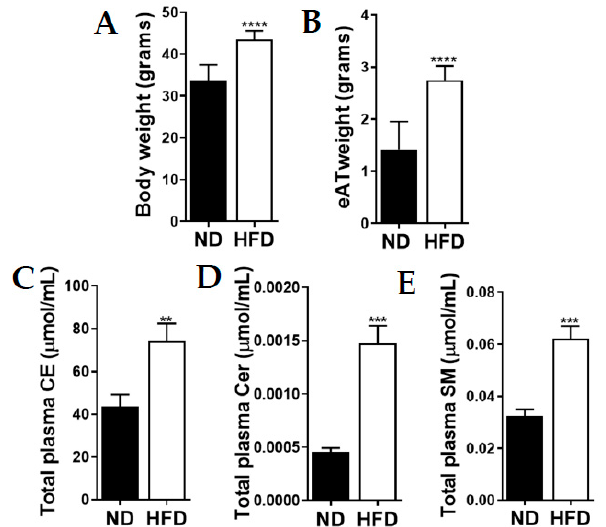
Figure 1. High-fat diet (HFD)-fed mice ( A ) weighed significantly more and showed ( B ) heavier epididymal adipose tissue (eAT) than normal diet (ND)-fed mice. HFD mice also showed elevated total fasting plasma ( C ) cholesteryl ester (CE), ( D ) ceramide (Cer) and ( E ) sphingomyelin (SM) levels. Mouse weight and eAT are expressed as means ± SD and all total lipid data are expressed as means ±